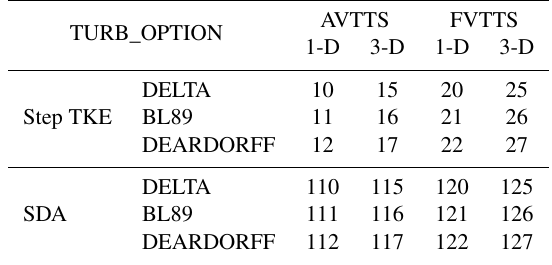
Table A1. Different turbulent options introduced in FLEXPART- AROME and their